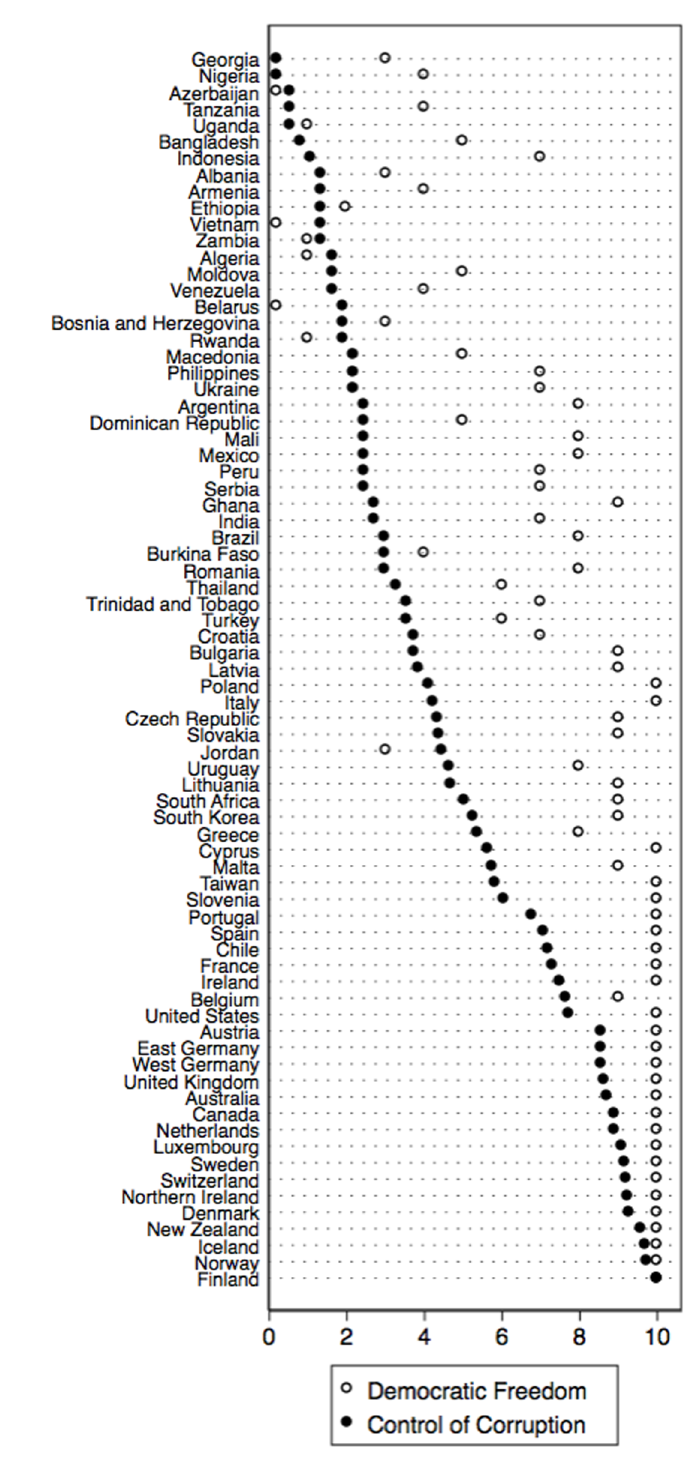
Figure 2. Control of corruption and democratic freedom across countries.